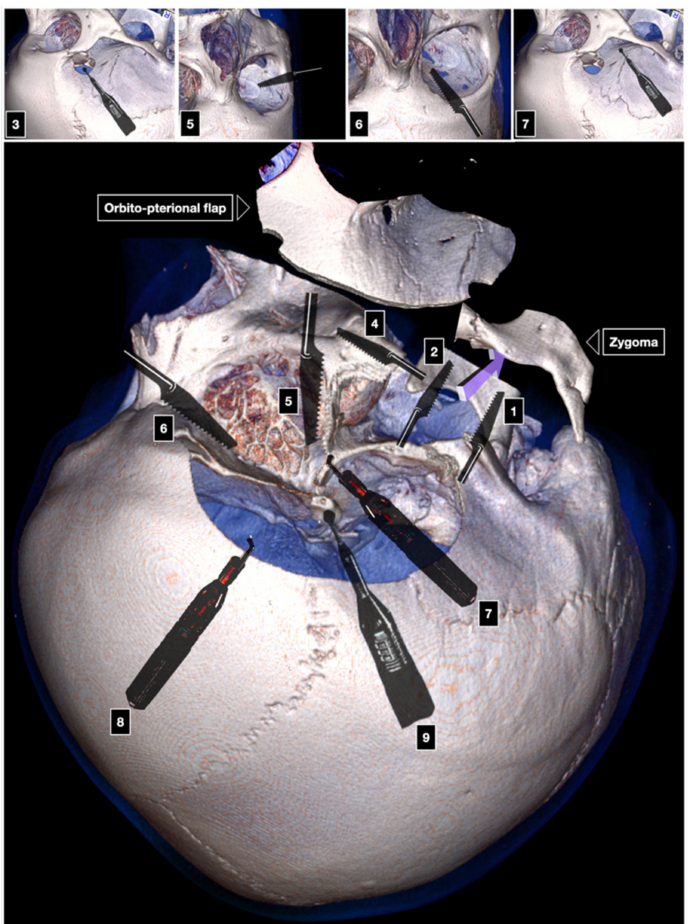
Figure 5. Al-Mefty technique of the two-piece COZ approach. 1: first cut; 2: second cut; 3: McCarty keyhole; 4: third cut; 5: fourth cut; 6: fifth cut; 7–8: romoval of the orbito-pterionla bone flap; 9: anterior